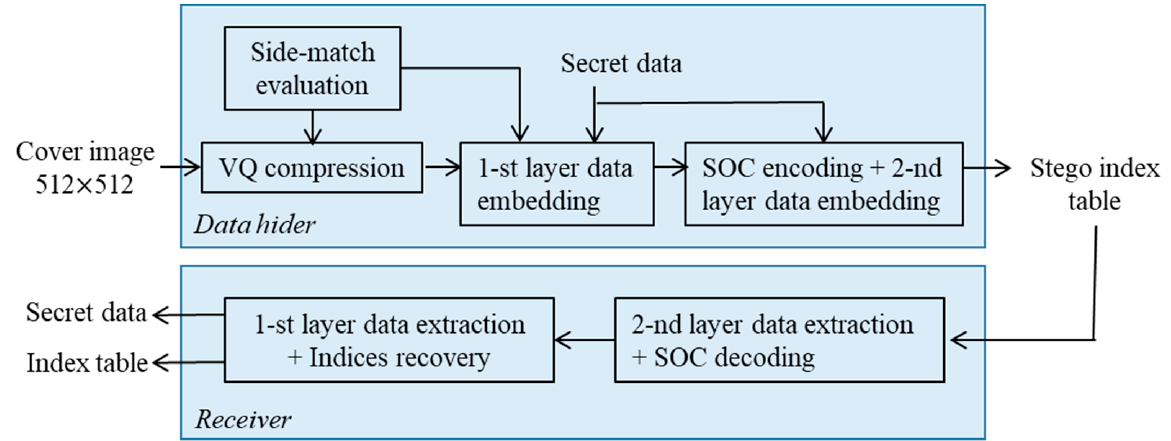
Figure 4. The flowchart of the proposed scheme.